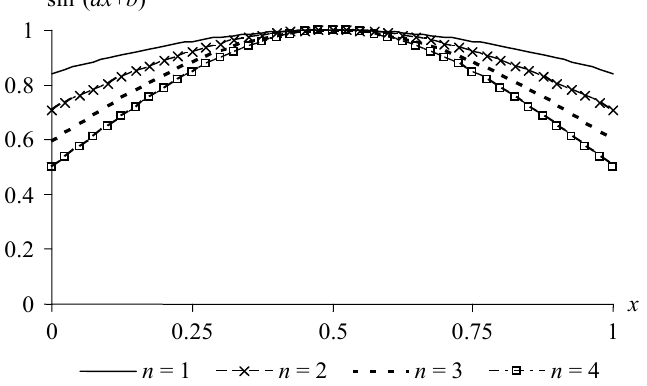
Fig. 3. Graphical illustrations of sin n ( ax + b ) for a = π –2 b , b = 1, and different values of the parameter n .